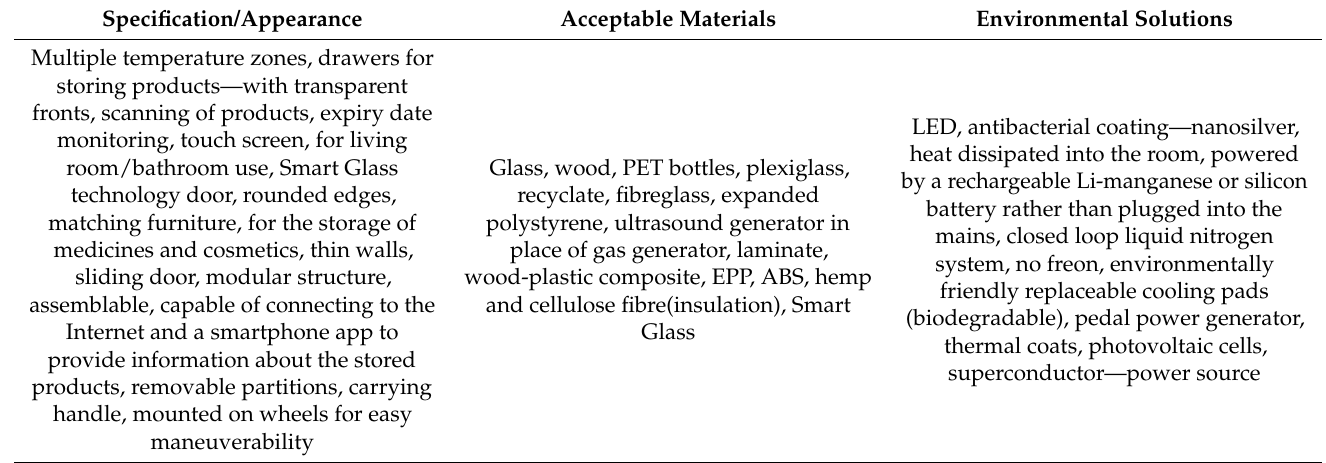
Table 3. Selected ideas gathered from the participants of the creativity